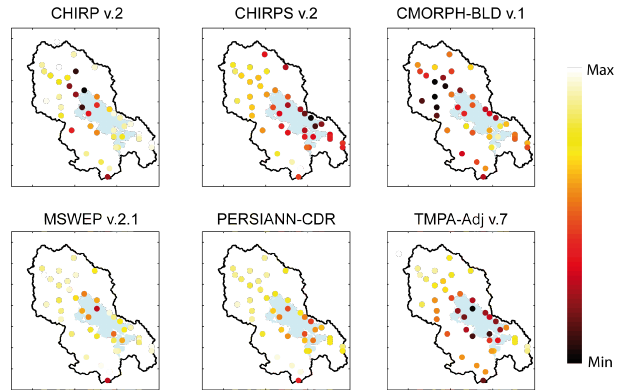
Figure 9. SPPs’ ability to forecast daily precipitation events rep- resented in the form of POD. POD = a/a + b , with “ a ” being the number of days on which both SPP and P ref detected precipitation and b the number of days on which only P ref detected precipitation events. The legend shows the range between min and max to focus on POD anomalies over Lake Titicaca. Grid cells located outside the Lake Titicaca basin were removed to facilitate